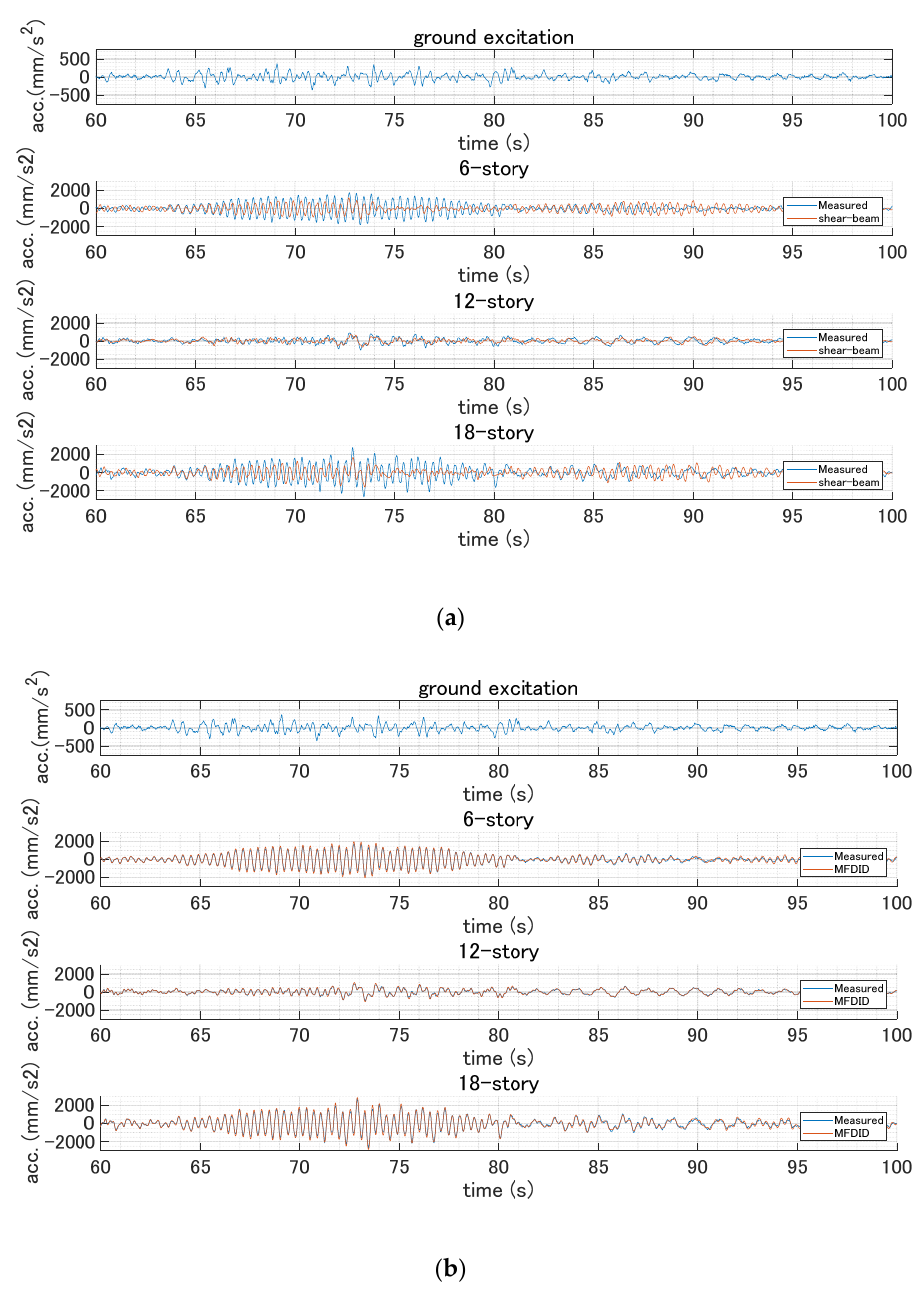
Figure 11. Comparison of time history response accelerations using experimental input excitation: ( a ) Measured and linear model fitted to the 3D model by parametric model updating (BMU method); ( b ) measured and updated linear model fitted to the experimental data by nonparametric system identification (SRIM method).